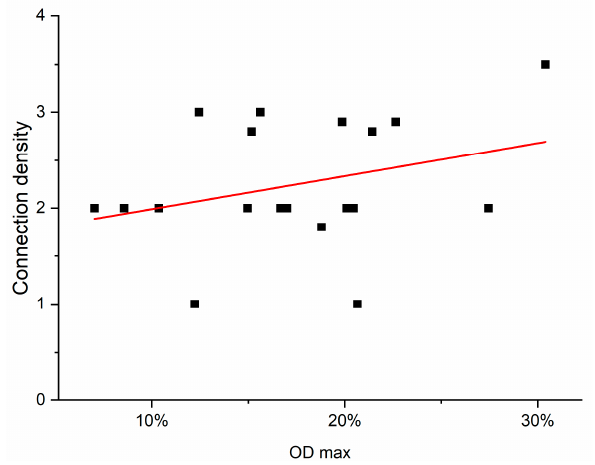
Figure 11. Correlation of the virtual maximum OD determined by cubic-spine interpolation and the connection density of the examined brain structures with the BoNT-A-treated CPu. The values come from animals finalized after 3 months. The connection density was taken from neuroVIISAS. A mean linear relationship with distance from the injection site was found (correlation coefficient is 0.22). The red line is the regression line calculated from the compared values.